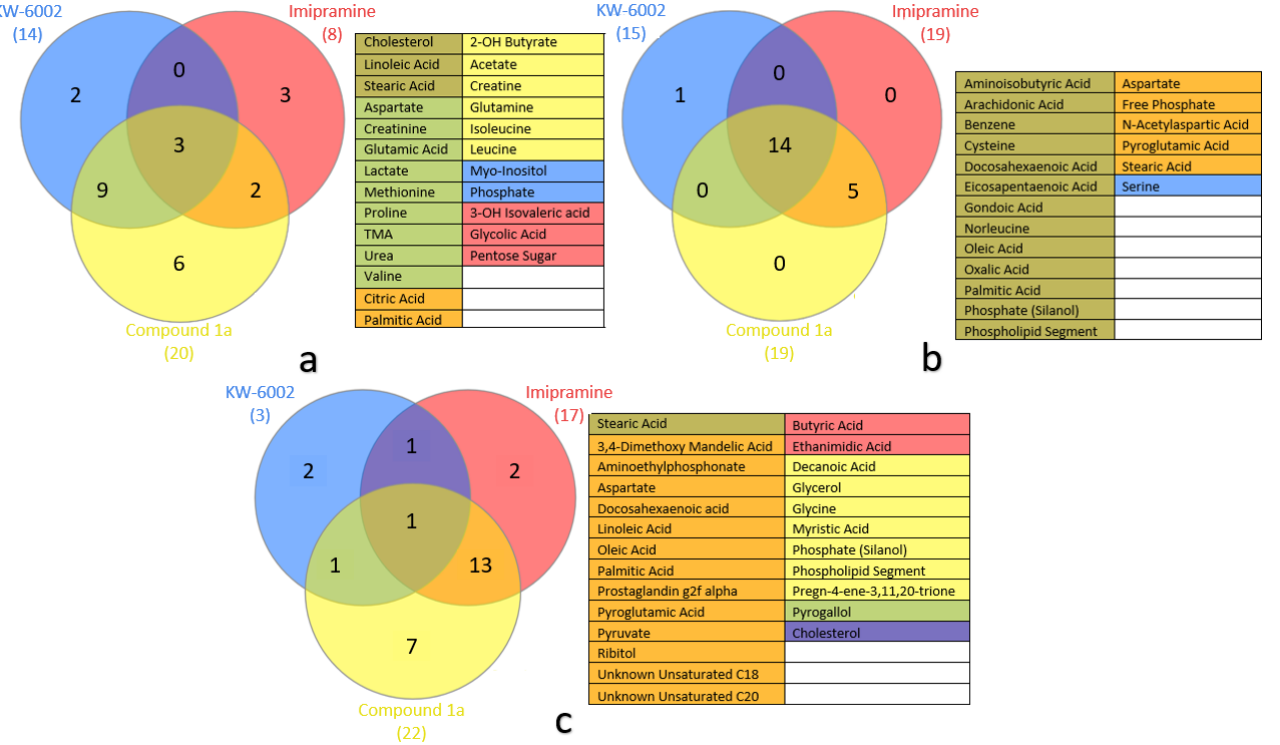
Figure 2. Venn diagrams illustrating the distribution of altered metabolites in ( a ) serum, ( b ) whole brain (excluding striata), and ( c ) striata. brain (excluding striata), and ( c )